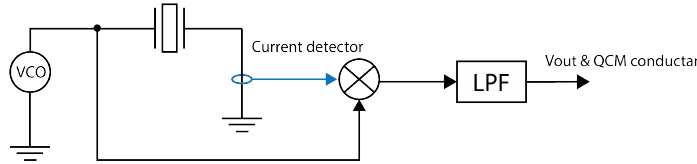
Figure 20. Circuit block diagram to obtain maximum conductance.